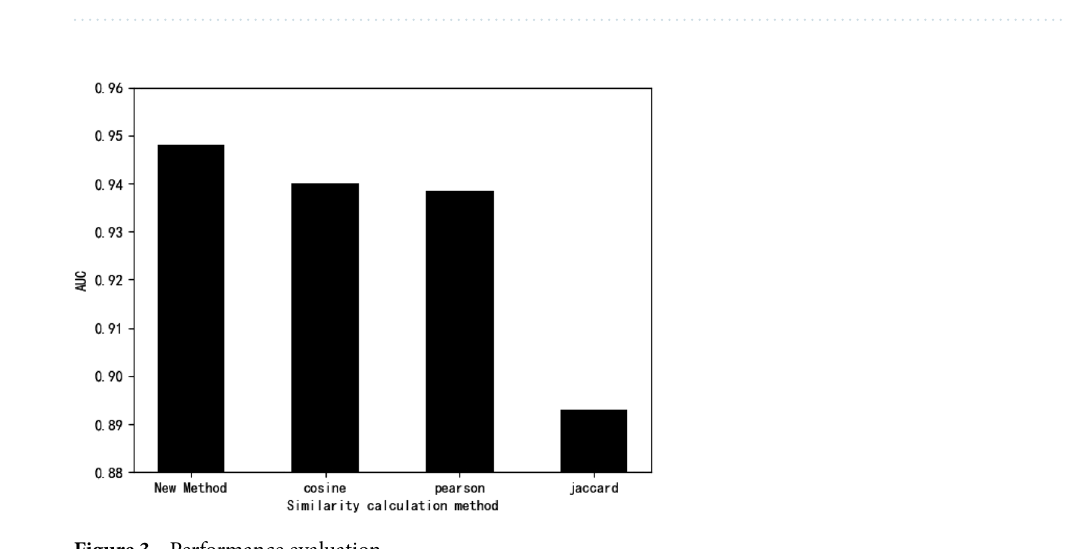
Figure 3. Performance